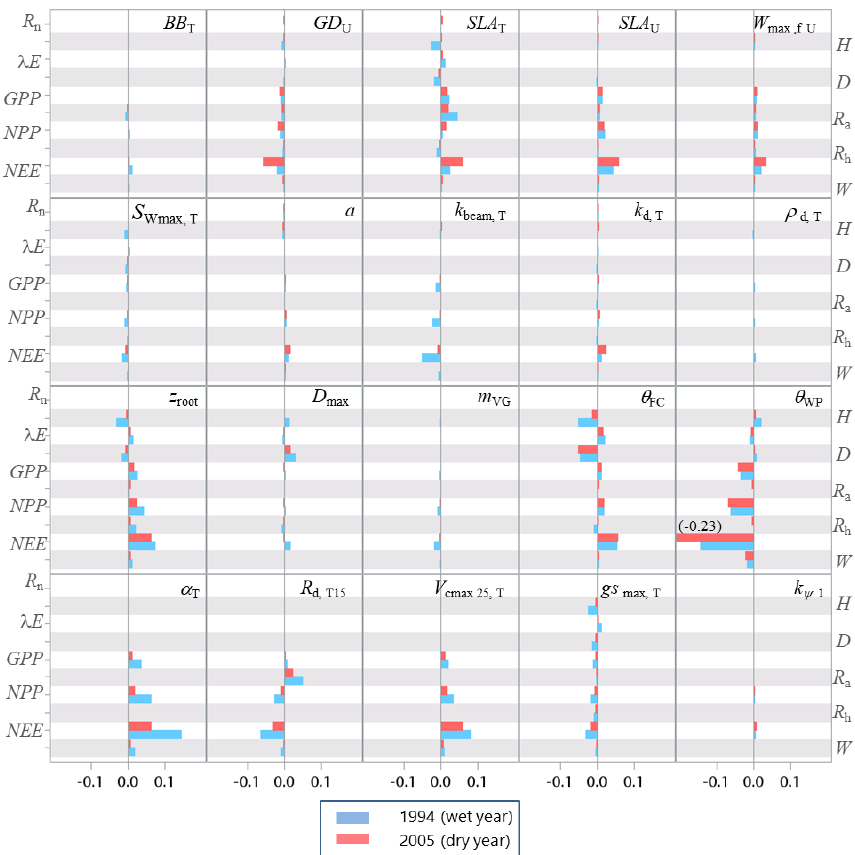
Figure 7. Relative sensitivity index values of the main variables related to the energy, water and carbon fluxes to model parameters for the years 1994 (wet, in blue) and 2005 (dry, in red) at the Le Bray site. The abbreviations of the variables (vertical axes) are explained in Table A1 and the parameter abbreviations (inset) are detailed in Table S1. The horizontal bars in each box gives the relative sensitivity of 10 variables listed along the y axis to the parameters named in the box. A positive value means that the output variable increased in response to an increase in the parameter